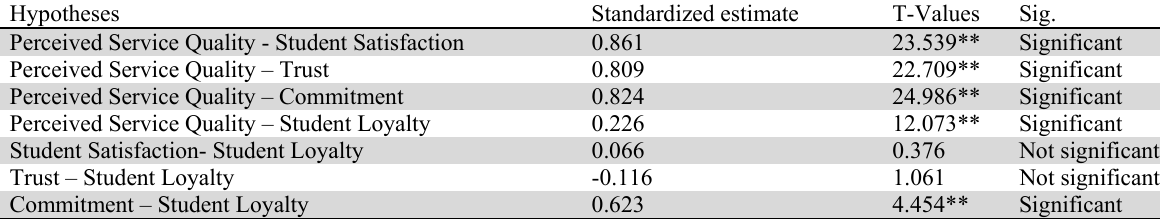
T-Statistics for Path Estimates